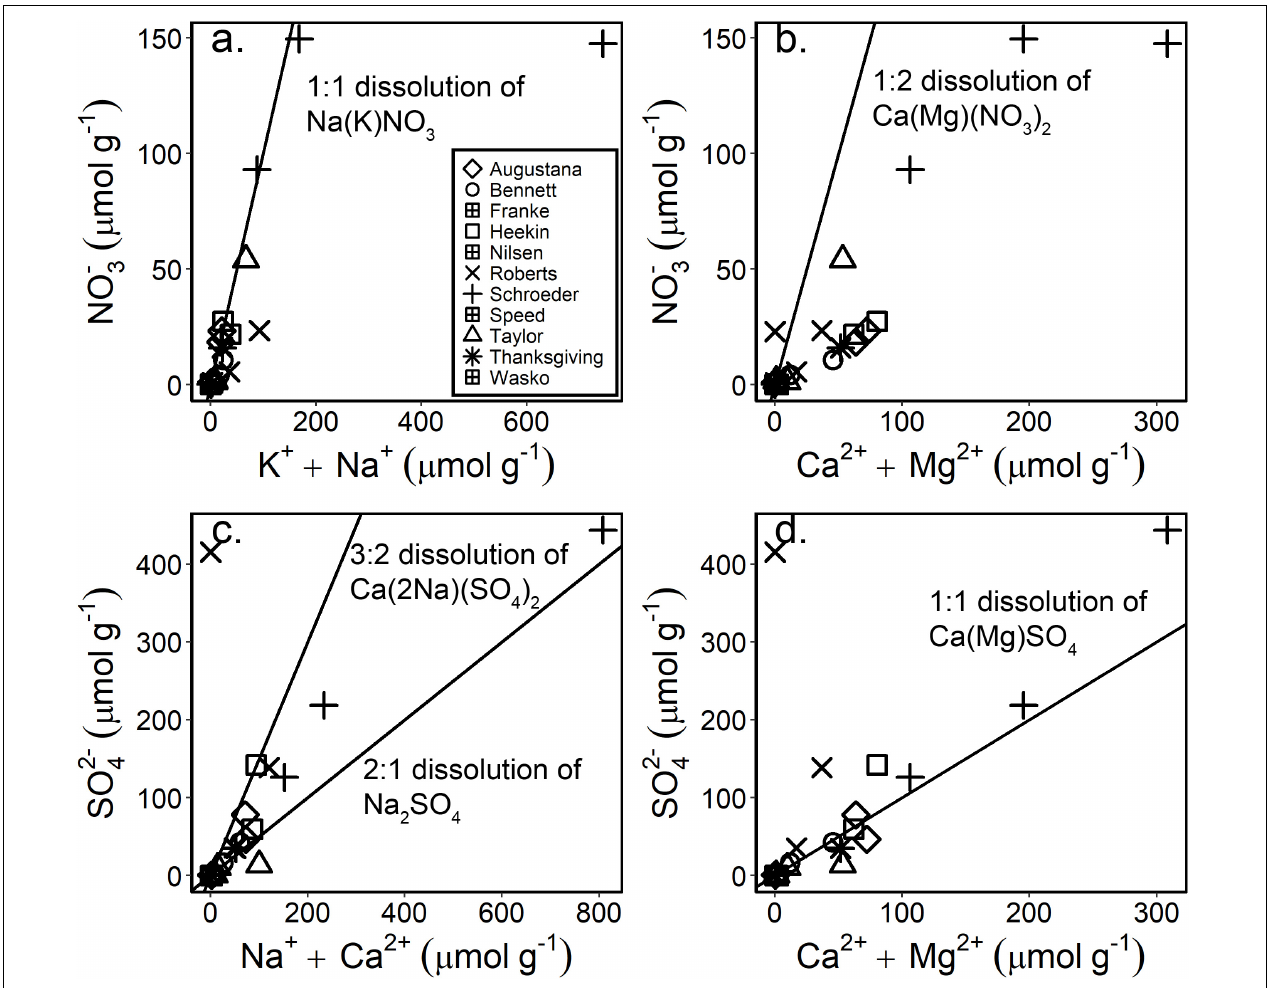
FIGURE 4 | Salt dissolution diagrams for the major NO 3 - (a,b) and SO 42 - (c,d) salts typically observed in high latitude polar desert soils. The solid black lines are dissolution lines, suggesting that samples which fall on the lines likely have salts derived from the ions represented on the x and y